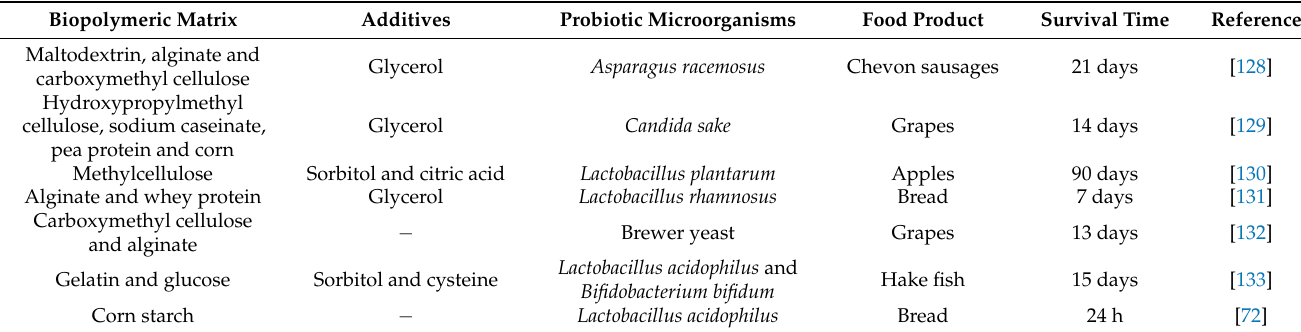
Table 5. Edible coatings-probiotics applied in food